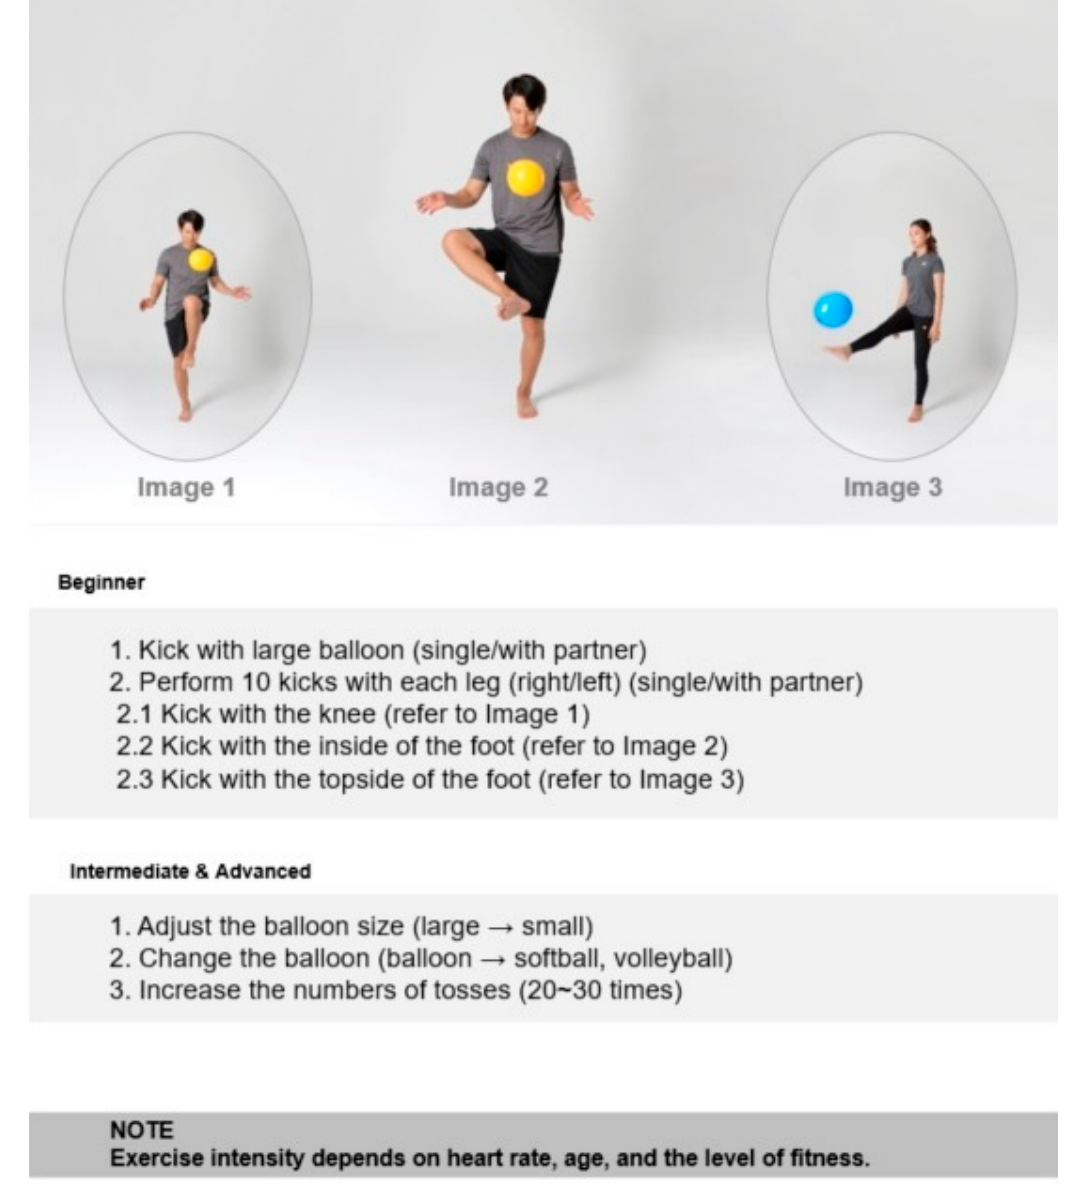
Figure A22. Detailed description and components of each movement in the “Balloon kick” balance exercise.